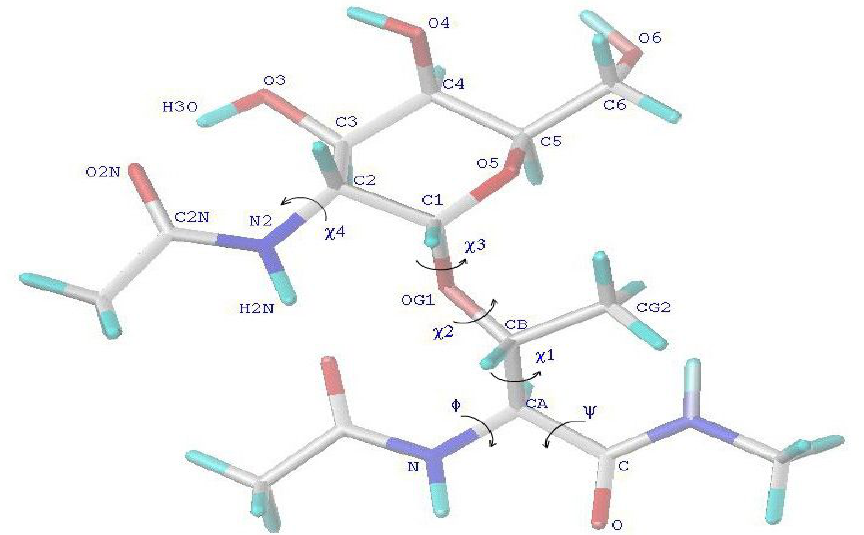
Figure 1 . Schematic representation of the N-acetyl -N’-methylamide of Thr-GalNAc